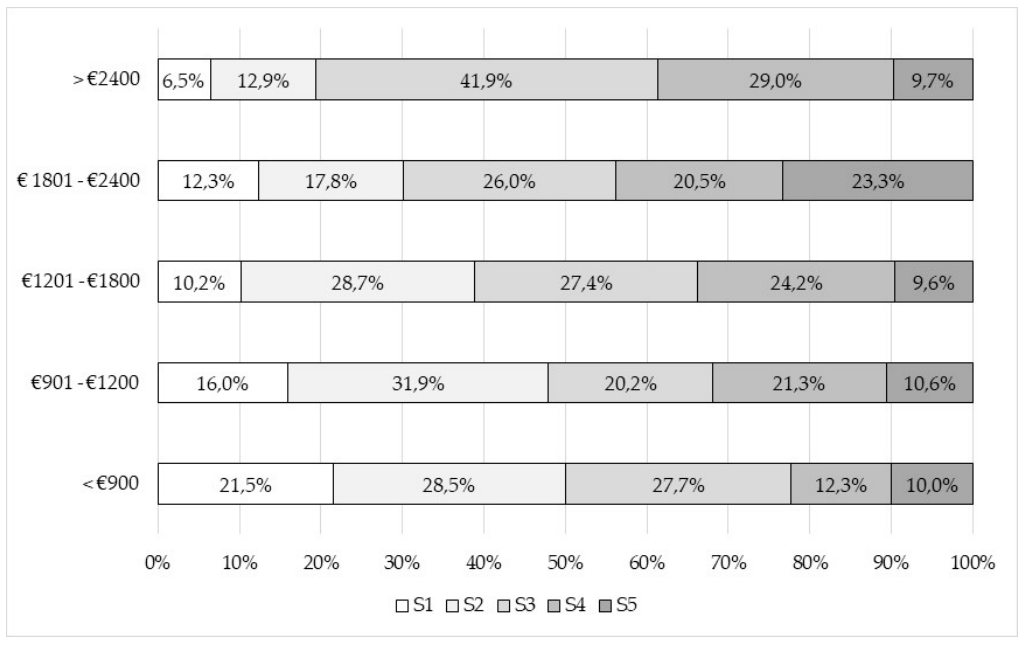
Figure 4. SAI distribution within income level categories.